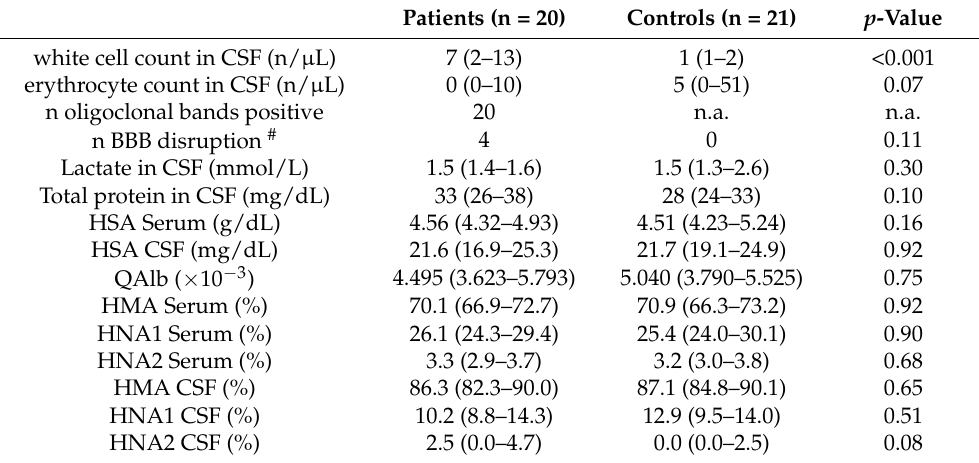
Table 2. Routine diagnostic parameters and albumin redox state in serum and CSF of patients (RRMS and PPMS) and controls.